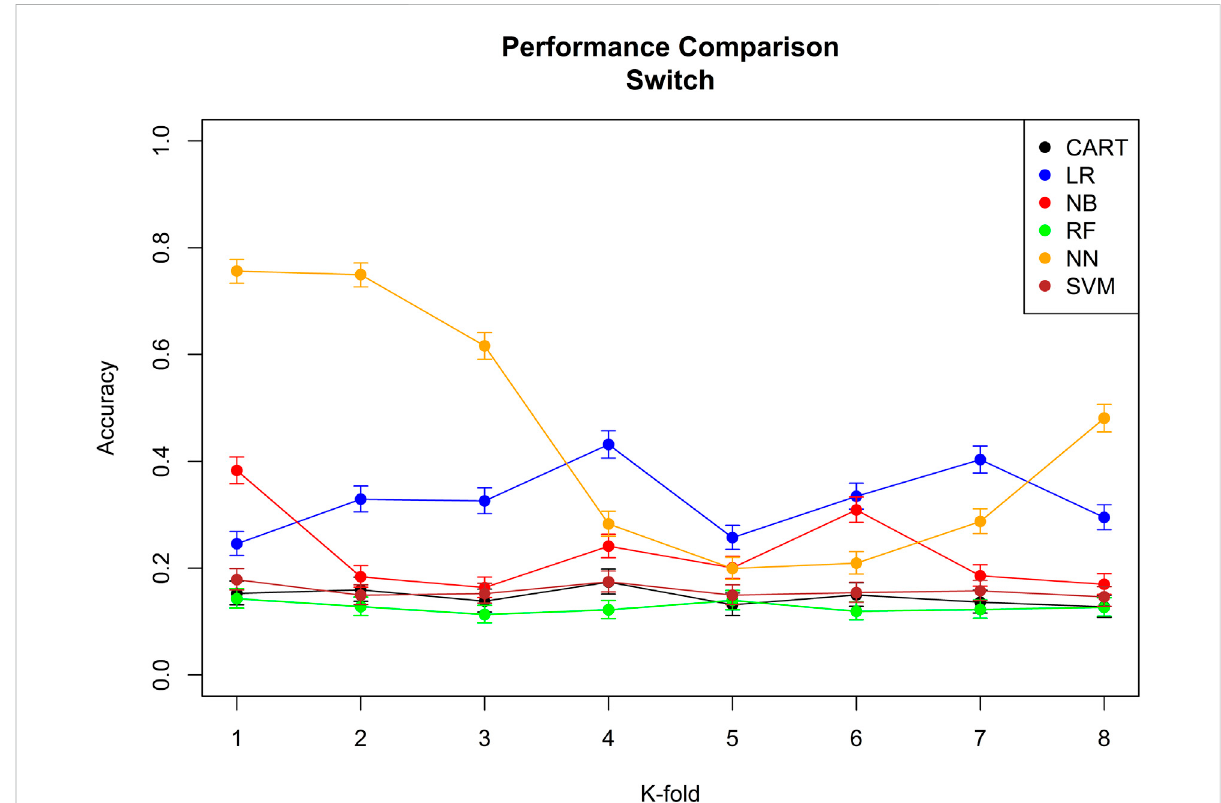
FIGURE 2 Performance comparison of all the six different machine learning/deep learning models used in approach 3 and the model ’ s accuracy of correctly classifying a switch. CART = classi fi cation and regression tree, LR = linear regression, NB = naïve Bayes, RF = random forest, NN = neural network, and SVM = support vector machine